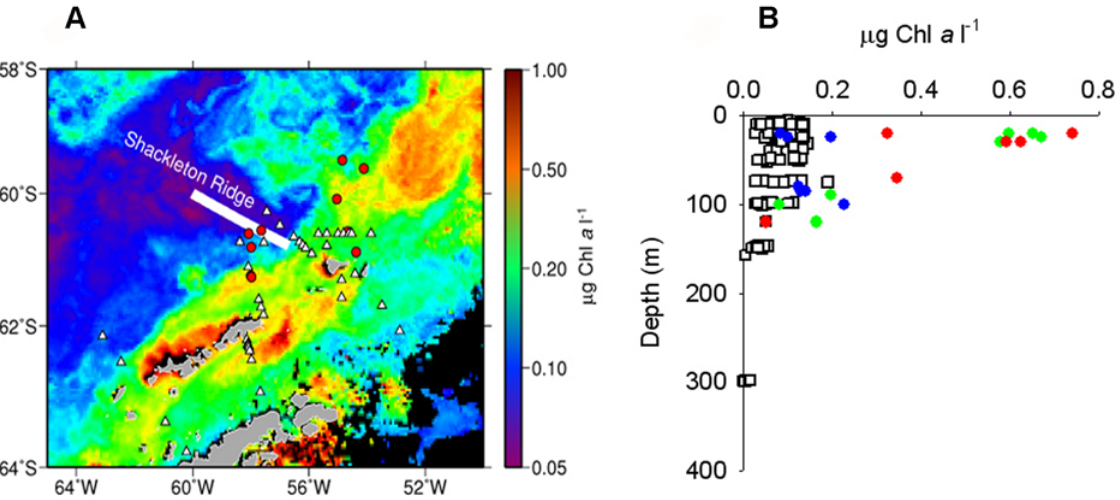
Figure 1. Sampling area and chlorophyll a distribution. (Panel A) MODIS-Aqua composite image of the chlorophyll- a gradient during 2004 summer. Red dots: summer 2004 sampling stations; white triangles: winter 2006 sampling stations. (Panel B) Depth profile of chlorophyll- a ( Chl a ) from summer 2004 cruise (blue circles=ACC water; green circles=mixed water; red circles=shelf water) and winter 2006 cruise (empty squares).